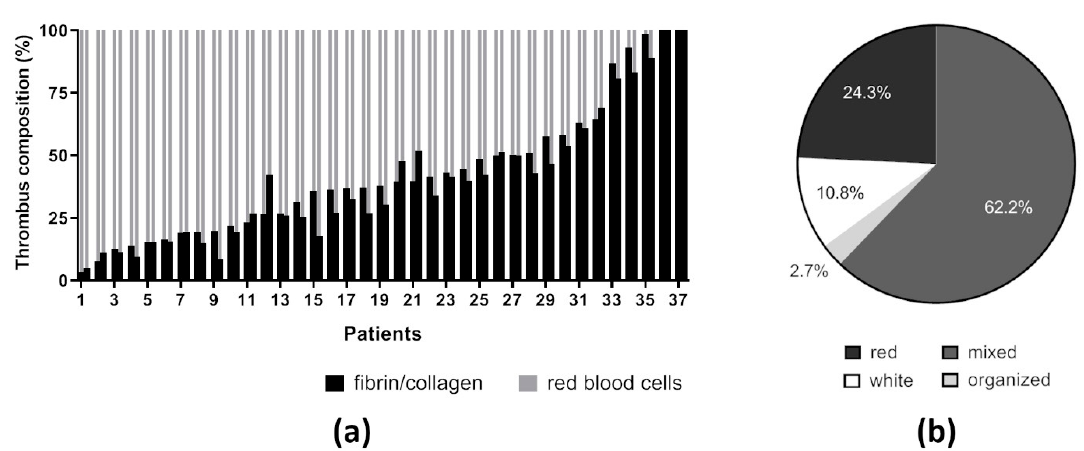
Figure 1. Characterization of thrombemboli. ( a ) Classification of occlusive thrombemboli due to their two main components: red blood cell-rich and fibrin / collagen-rich areas in percentage of total area for two di ff erent thrombemboli slices represented by two separate bars per patient. ( b ) Categorization of thrombemboli based on quantitative morphological area analysis.